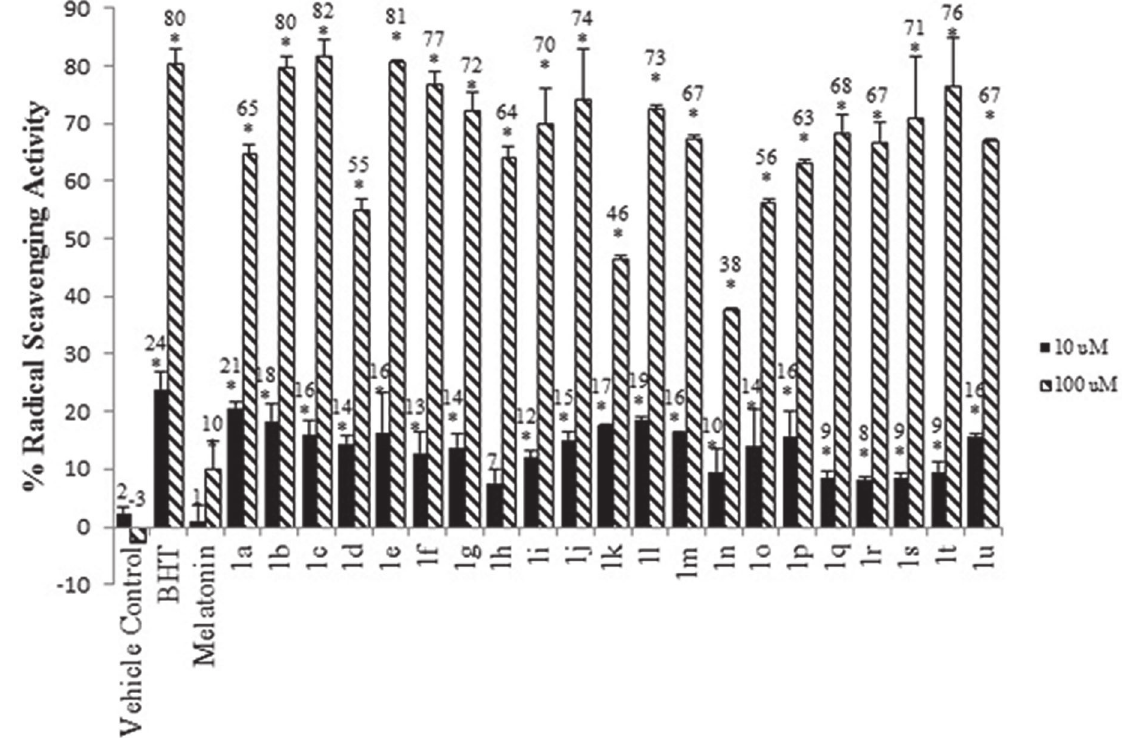
FIGURE 2 - Radical scavenging activities of the novel compounds according to the DPPH assay. Bars represent “% RSA Mean ± standard deviation”. Melatonin (MLT) and butylhydroxytoluene (BHT) were used as reference compounds. The results were obtained by studying three different groups for each molecule. Statistically significant values (p <0,05) were expressed with